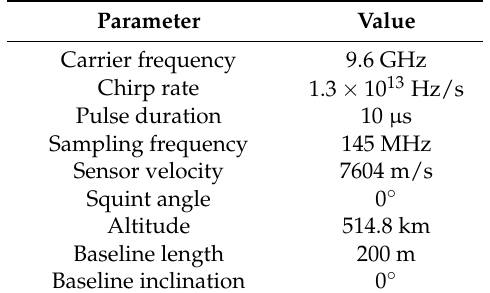
Table 1. Simulation Parameters of the InSAR System.